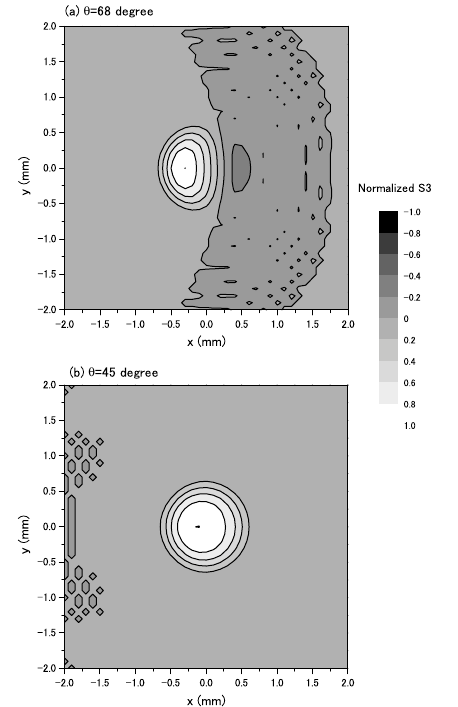
FIG. 6. The spatial distributions of S with (a) (cid:1) 68 (cid:9) and (b) (cid:1) 45 (cid:9) . The fundamental photon energy is 400 eVand the screen position is 30 m away from the light source. The helicities of the white- and black-colored regions are